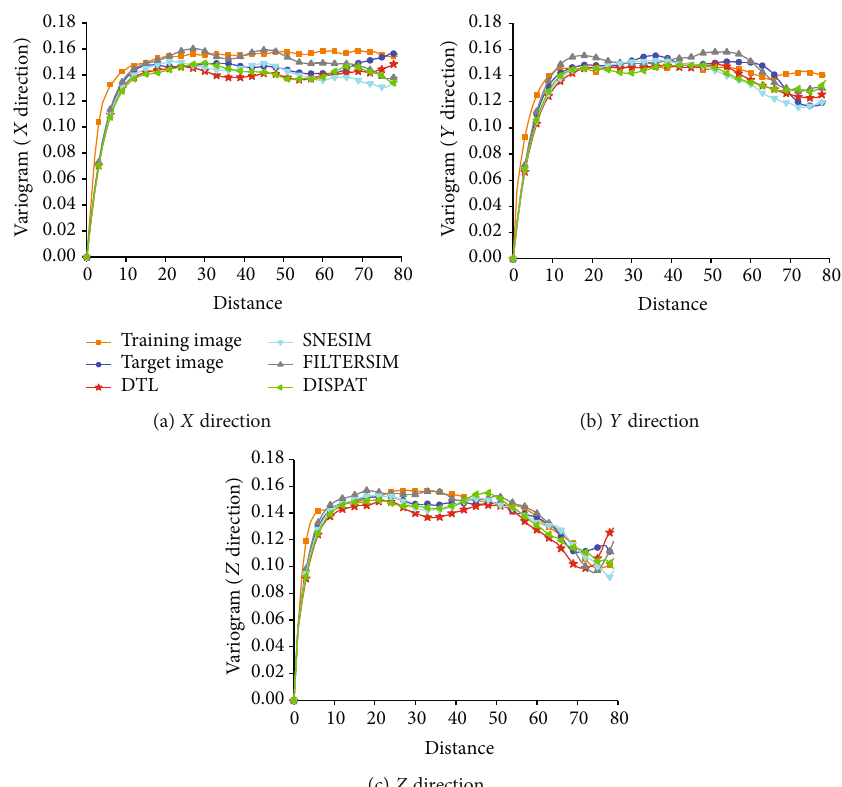
Figure 19: Variogram curves of sandstone images from the TI, the target image, and reconstructed images using SNESIM, FILTERSIM, DISPAT, and DTL in three